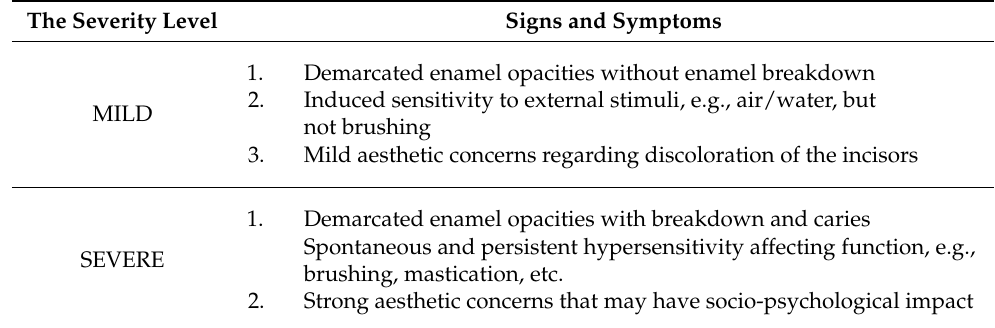
Table 3. The severity levels according to the EAPD classification. The Severity Level Signs and Symptoms 1. Demarcated enamel opacities without enamel breakdown 2. Induced sensitivity to external stimuli, e.g., air/water, but MILD not brushing 3. Mild aesthetic concerns regarding discoloration of the incisors 1. Demarcated enamel opacities with breakdown and caries Spontaneous and persistent hypersensitivity affecting function, e.g., SEVERE brushing, mastication, etc. 2. Strong aesthetic concerns that may have socio-psychological